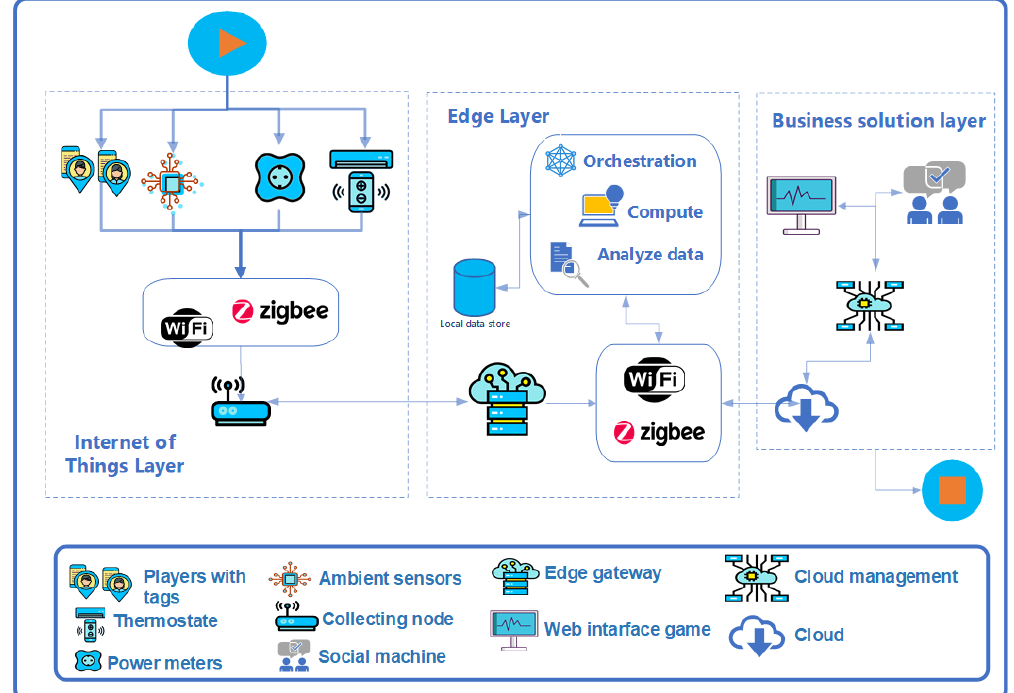
Figure 6. Data-flow chart of the evaluation